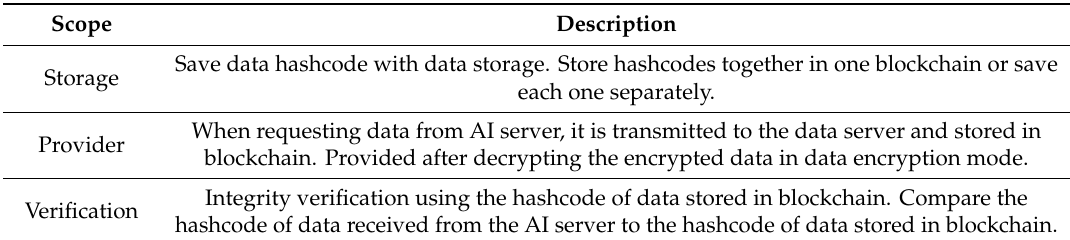
Table 2. Construct of